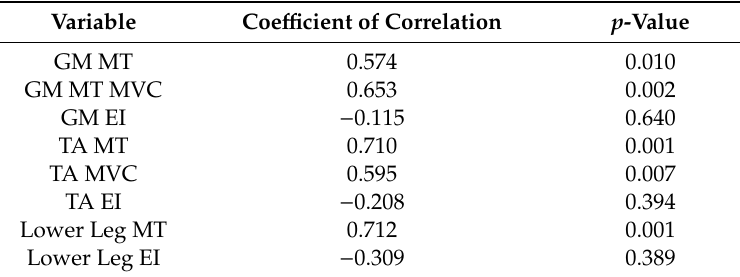
Table 3. Correlations between muscle ultrasound variables and the MNA-SF test.